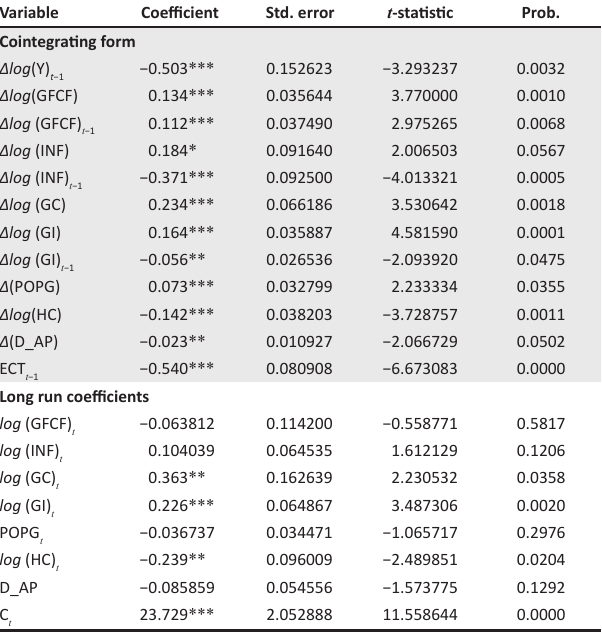
TABLE 2-A1: Autoregressive distributed lag result – long-run and short-run estimates. Variable Coefficient Std. error